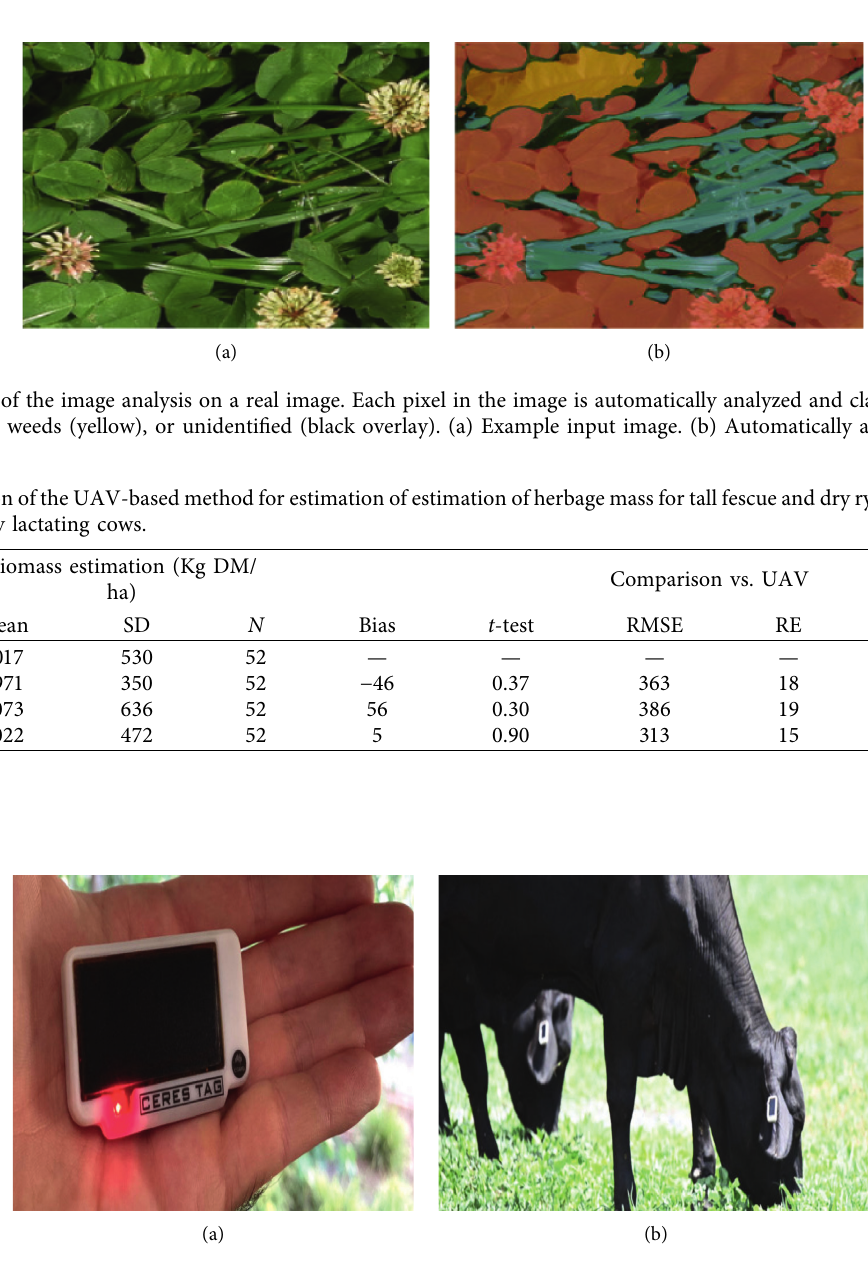
Figure 2: Sensor (a) and sensor applied to grazing stock